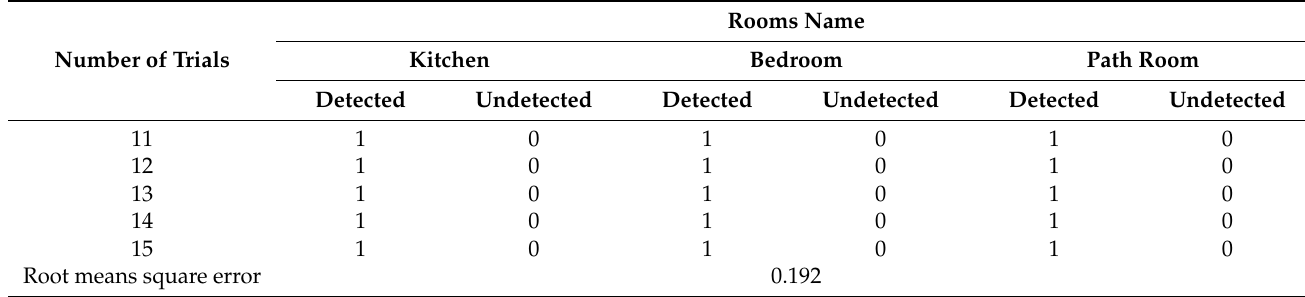
Table 3. Normalized confusion matrix.